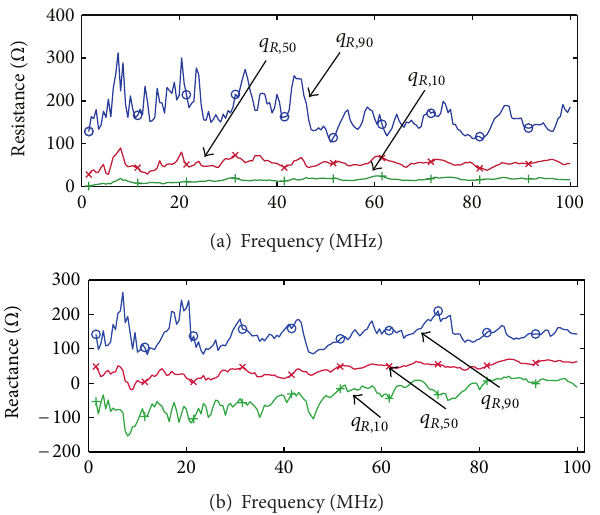
Figure 7: Quantiles of the reactive component of the optimal and power matched receiver impedance. Three probability values are considered, that is, 20, 50, and